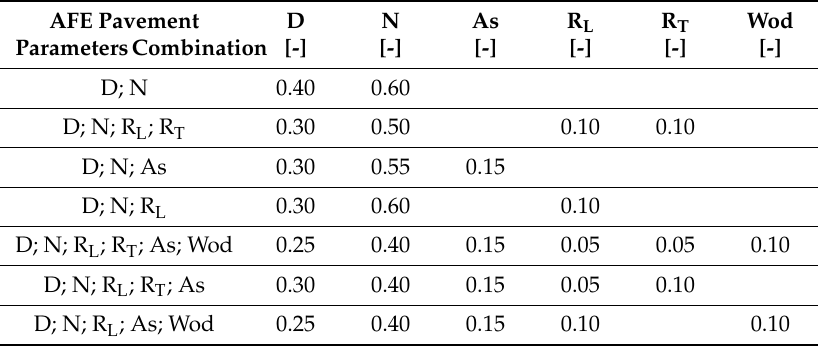
Table 1. Weights for various systems of AFE pavement parameter combination when calculating the APCI